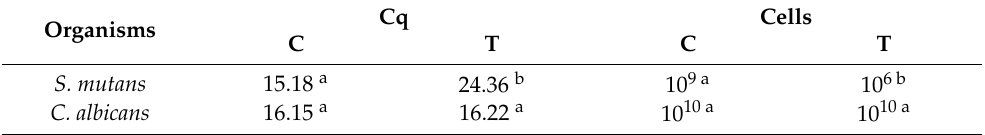
Table 2. The number of organisms detected by quantitative real-time PCR